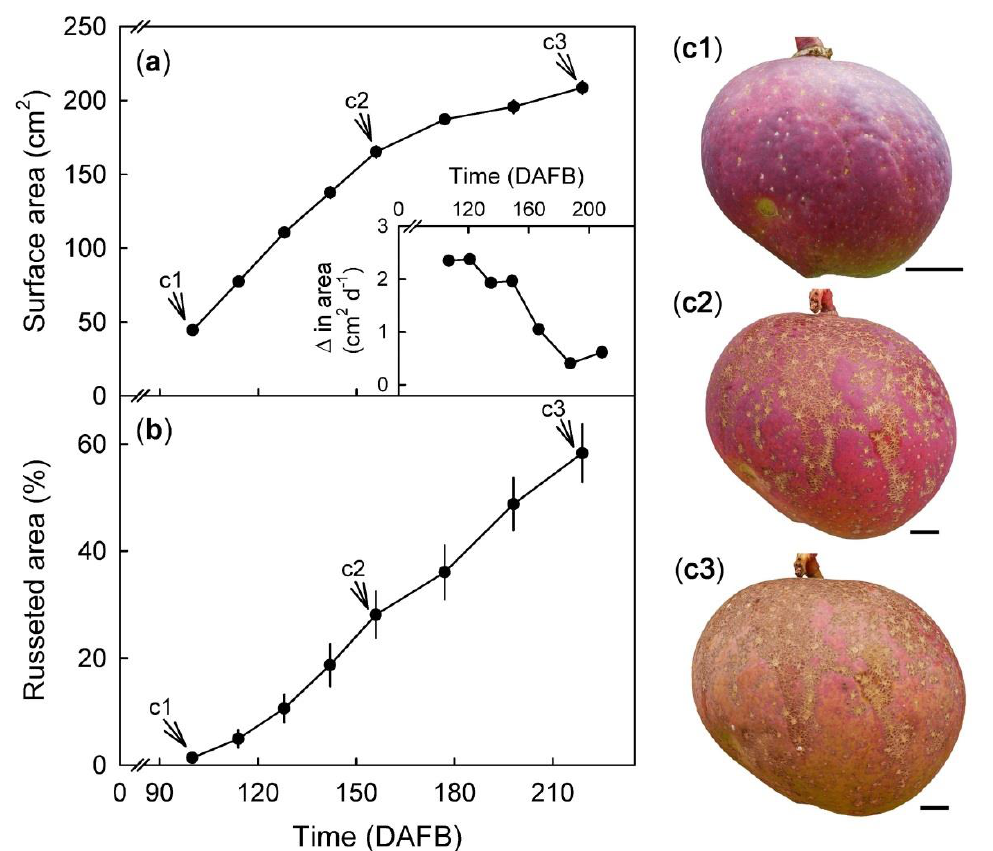
Figure 2. Change in fruit surface area (cm 2 ) and rate of surface expansion ( a and a inset ) with time (days after full bloom, DAFB). Percent of skin with russet in developing fruit ( b ) calculated from a defined area of the fruit cheek. The same fruit was photographed at 100, 156, and 216 DAFB (see arrows). Pictorial representation of russet progression in a developing ‘Apple’ mango fruit ( c1 – c3 ). Scale bar is 10 mm. Data represent means ± SE of 19 replicates.